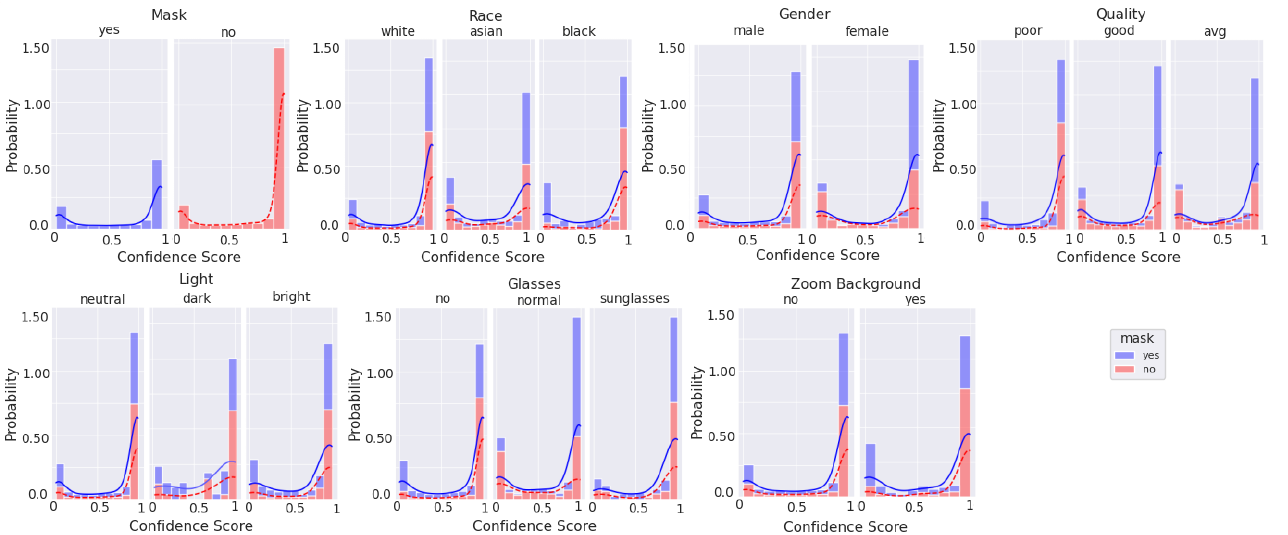
Figure 11. Histogram of categorical labels vs. confidence scores for all image qualities, as evaluated via BRISQUE, using the augmented MobileNetv2 model. For each category and its labels, ‘mask’ and ‘no mask’ data bins are stacked. The solid and dashed lines represent the KDE for ‘mask’ and ‘no mask’ image scores,